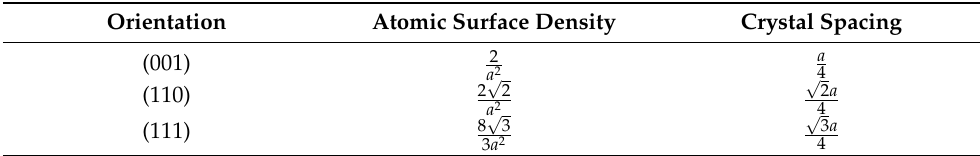
Figure 4. A snapshot of the atomic structure near the crack tip, with the atoms colored according to the coordination numbers. Table 2. Crystal properties of GaAs in different crystal